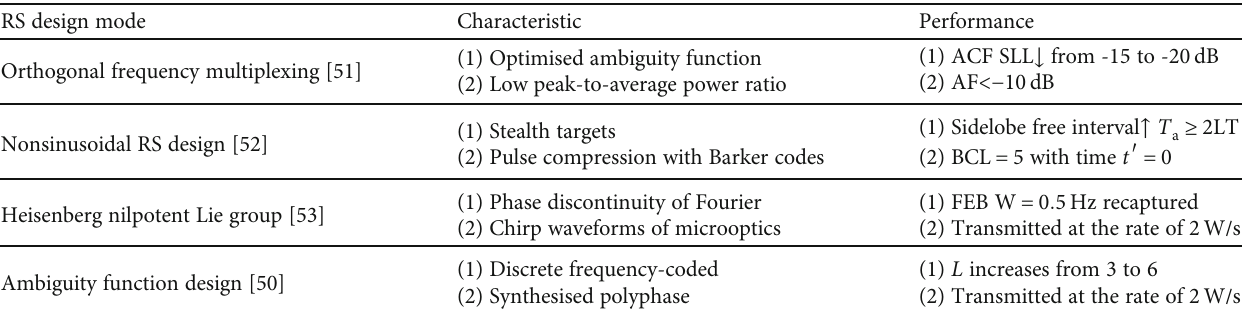
Figure 4: Radar signal design methods. Table 1: Signal performance comparison of di ff erent design